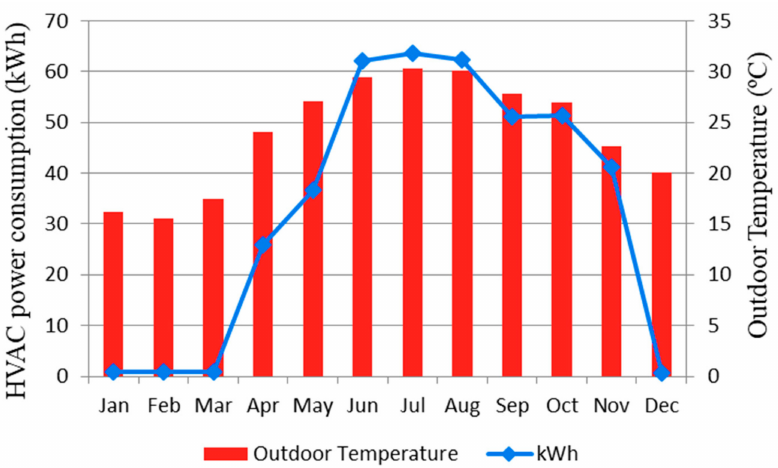
Figure 7. Outdoor temperature and HVAC system power